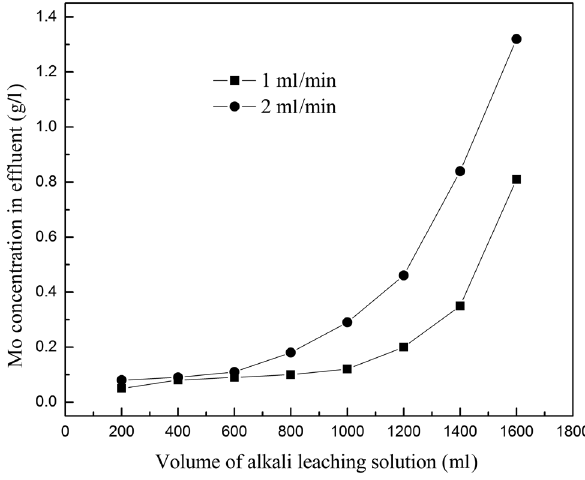
Figure 3: The dynamic adsorption curve of D314 resin.